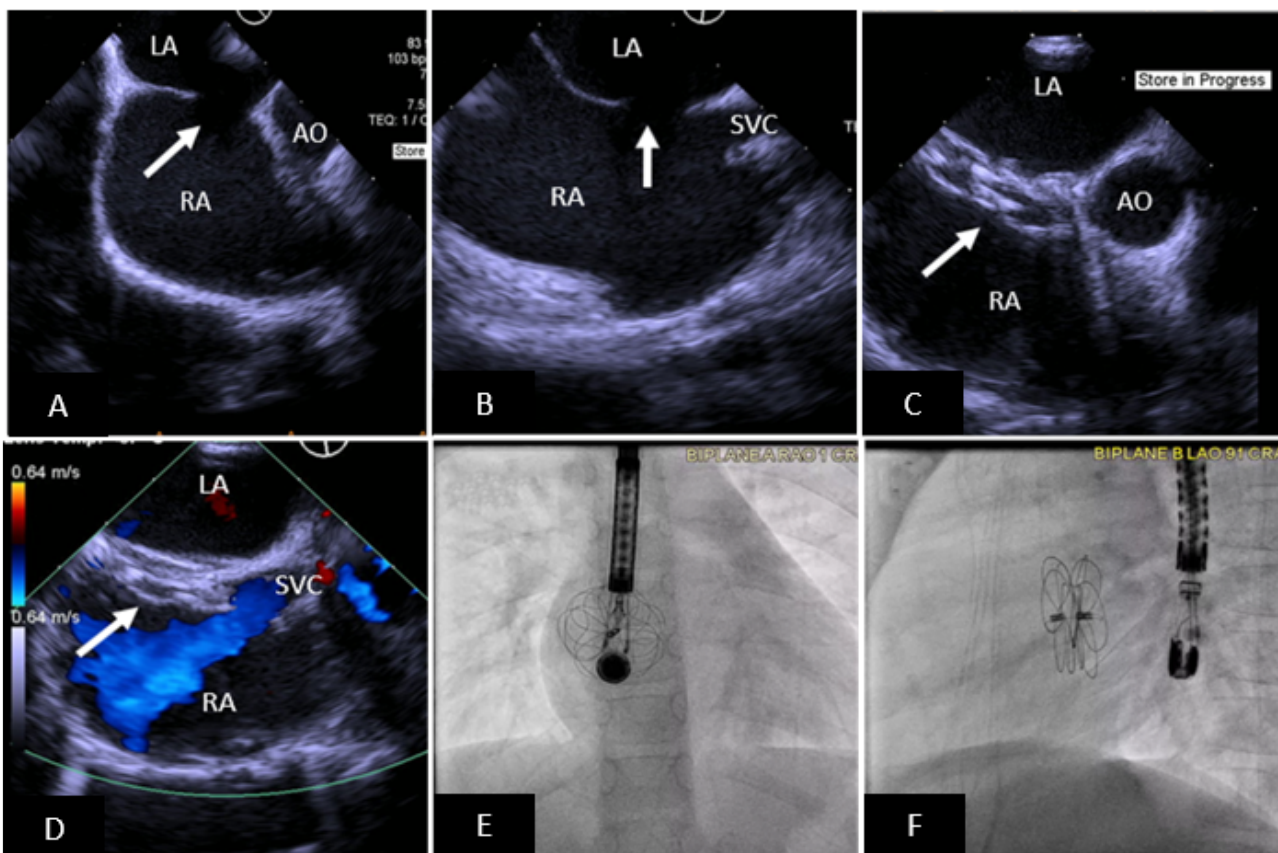
Figure 2. Transcatheter ASD closure with Gore Cardioform ASD Occluder. ( A ) 45° TEE view showing secundum ASD (arrow) with deficient aortic rim. ( B ) 90° TEE view showing high secundum ASD (arrow) with small SVC rim. ( C ) Well positioned ASD device (arrow) in same view as ( A ), the device does not indent the aortic root. ( D ) Well positioned ASD device in same view as ( B ) without obstruction to SVC flow. ( E , F ) Anteroposterior and lateral fluoroscopic images showing device position after release. SVC = superior vena cava, AO = aorta, RA = right atrium, LA = left atrium.